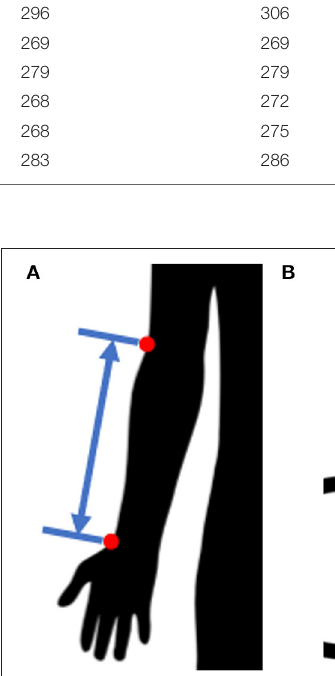
FIGURE 3 | Anthropometric forearm measurements: (A) radiale-stylion length, and (B) flexed forearm circumference.